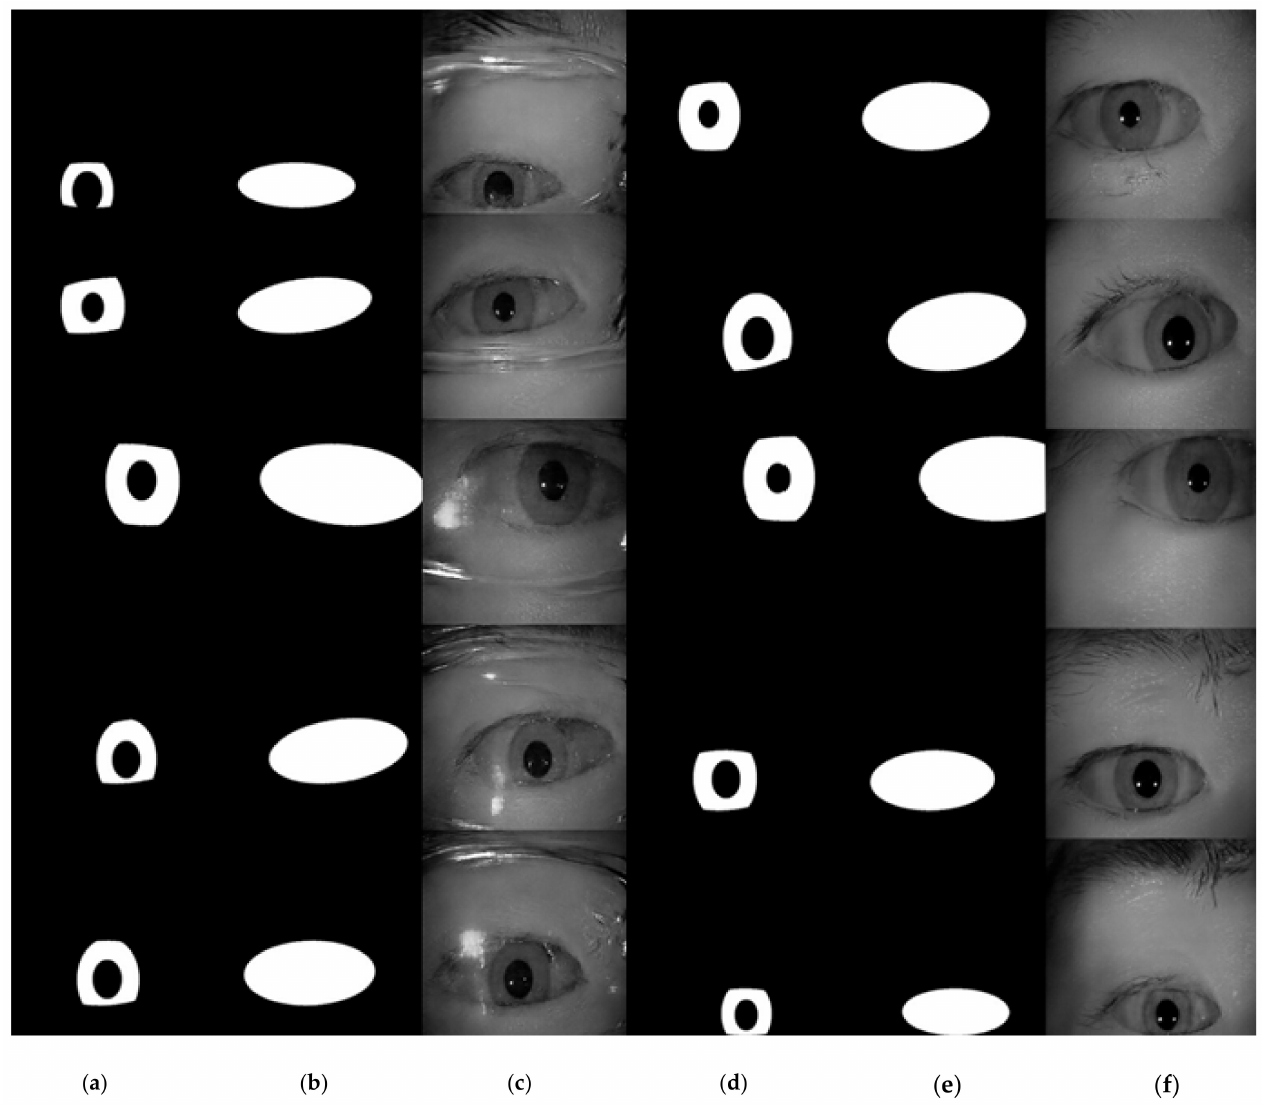
Figure 17. The examples of generated images (trained with ICE dataset, with and without glasses). ( a , d ) generated iris mask; ( b , e ) generated periocular mask; ( c ) generated image with glasses; ( f ) generated image without